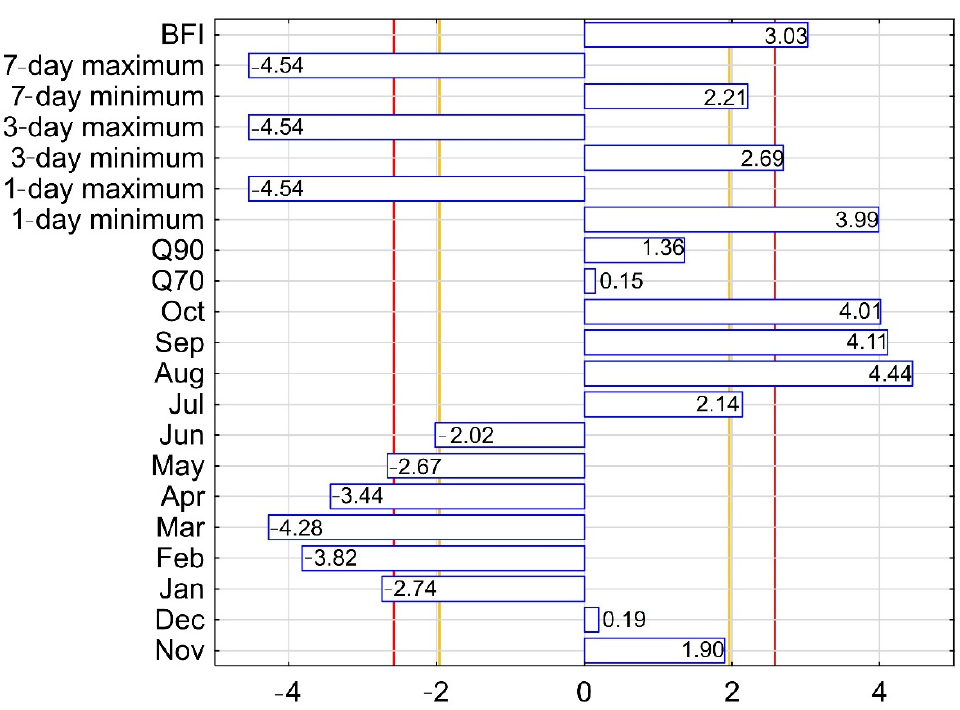
Table 2. Results of trend analyses for water flows at the Uniejów hydrological station with and without the Jeziorsko dam reservoir.